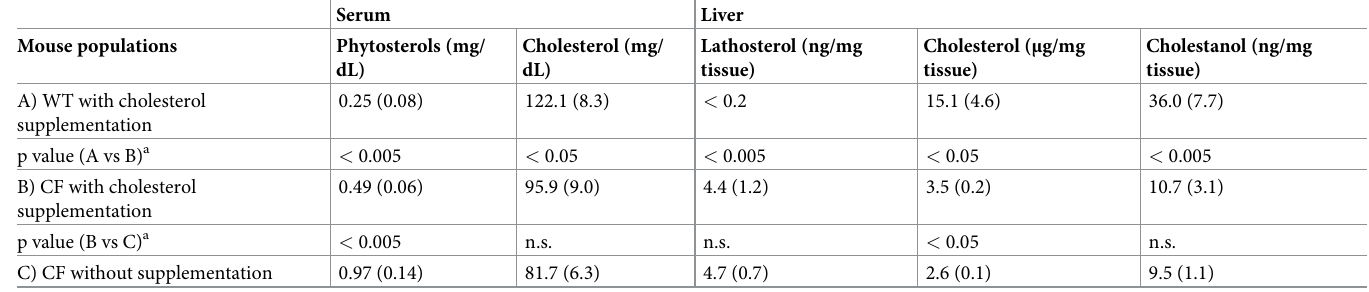
Table 5. Sterol levels in supplemented CF mice in comparison to supplemented WT and no supplemented CF mice. Mouse